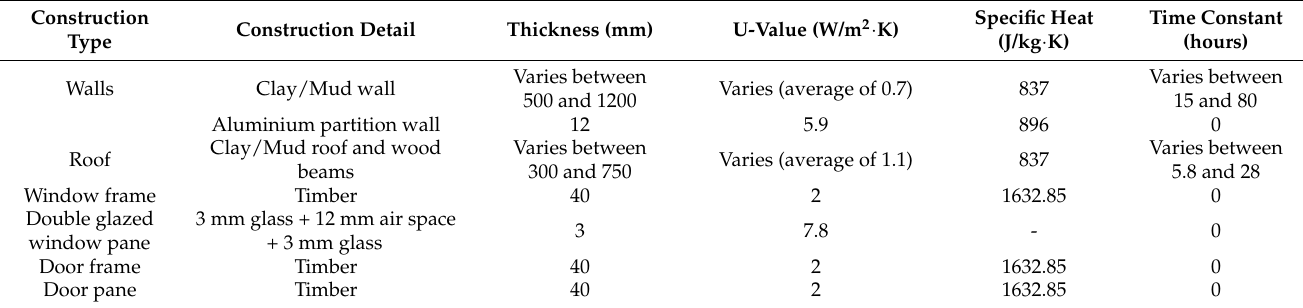
Table 4. Construction details of Al Wafi